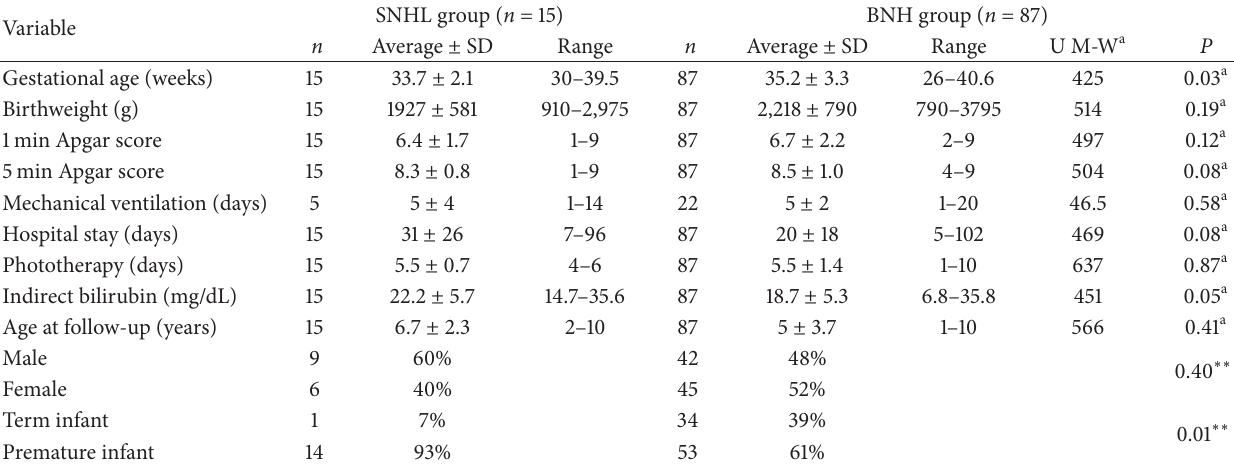
Table 2: Clinical characteristics of groups of children with SNHL and BNH with Exchange transfusion ( 𝑛 = 102